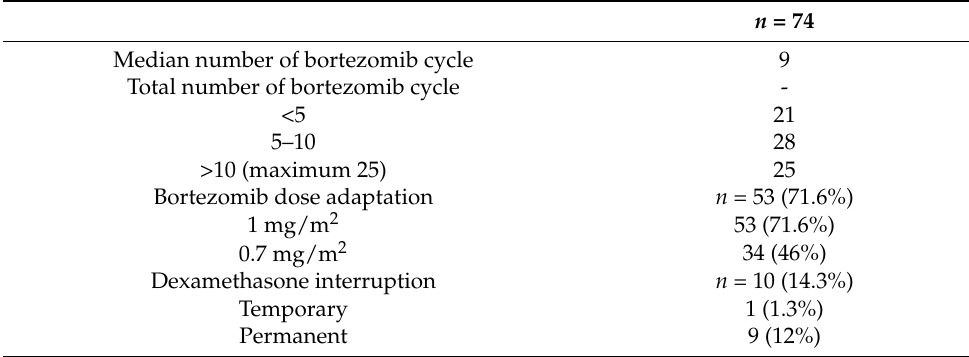
Table 4. Treatment dose